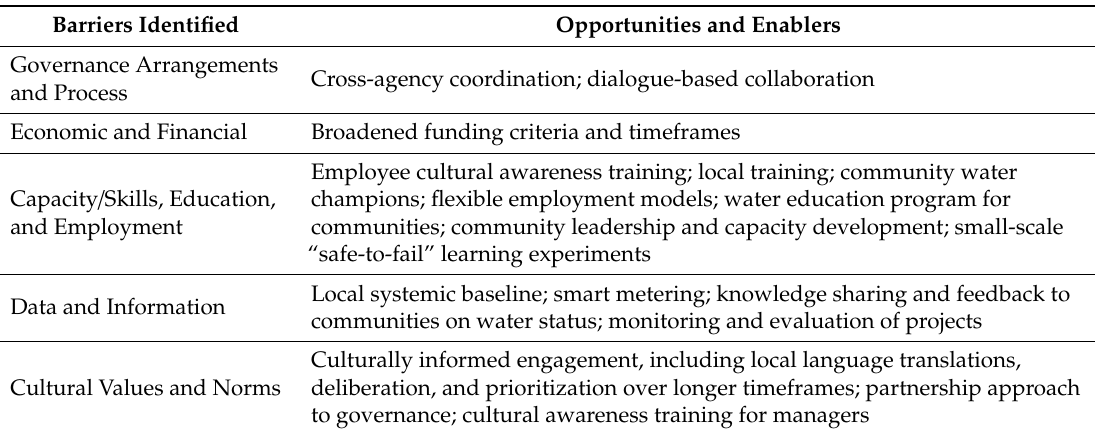
Table 3. Opportunities and enablers for tackling barriers to collaborative sustainable water